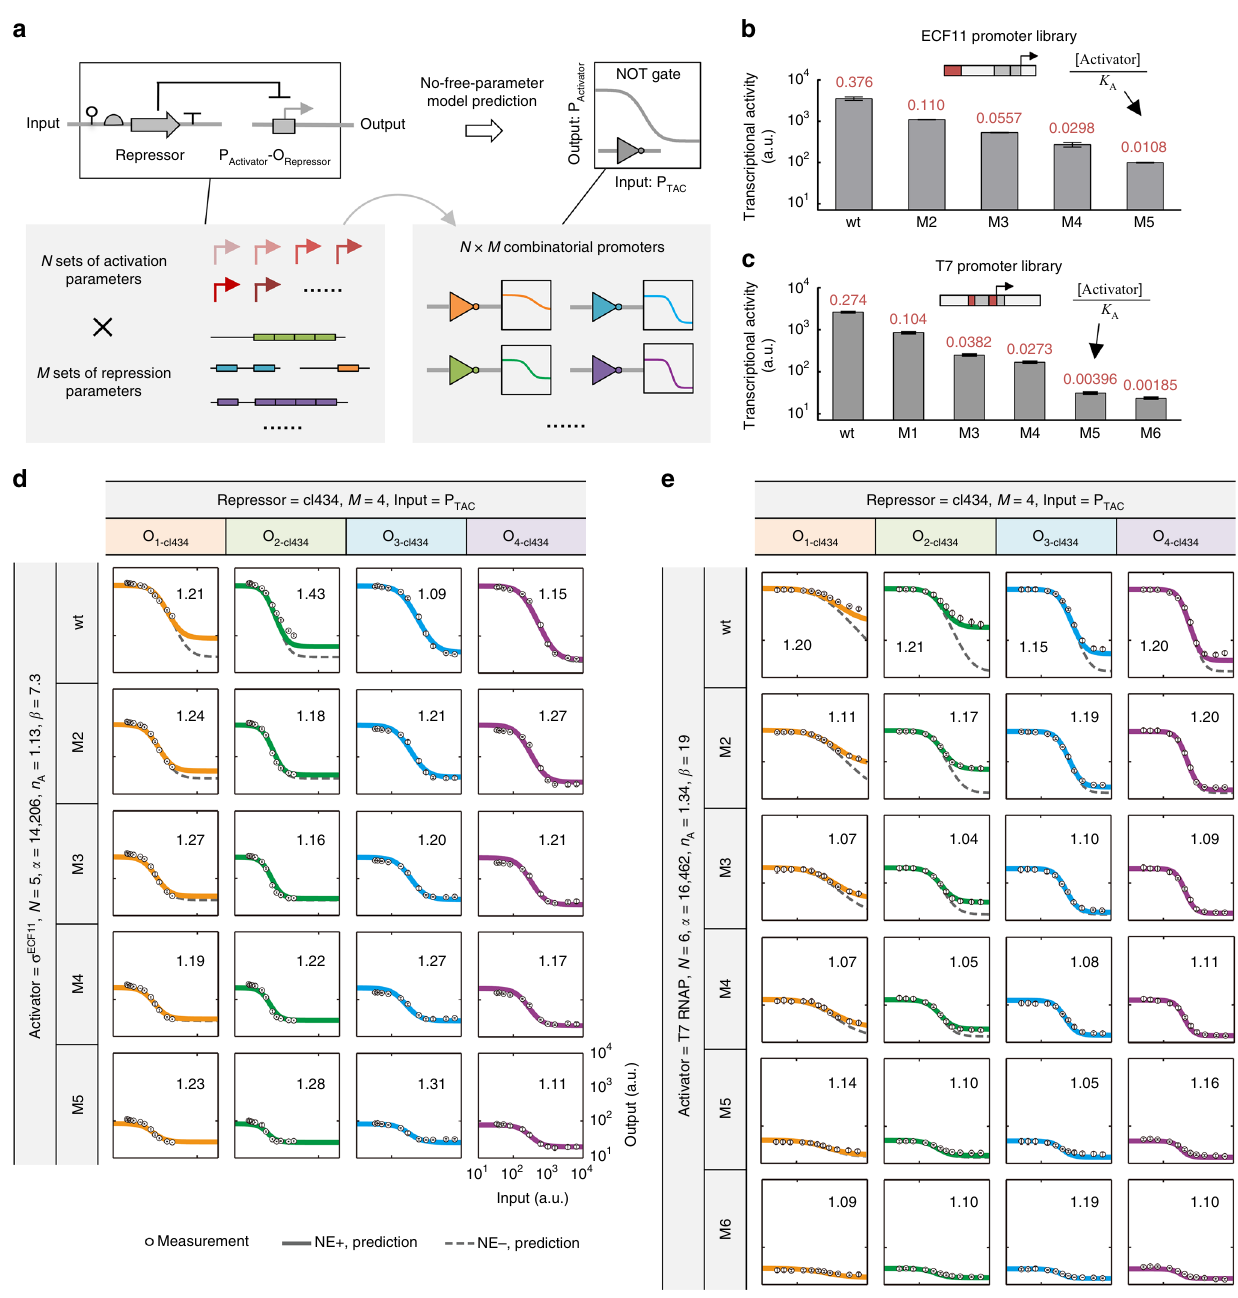
Fig. 4 Activation- and repression-dependent parameters allow the design of combinatorial promoters. a Schematic representation of the combination of N sets of activation-dependent parameters from promoter cores and M sets of repression-dependent parameters from operators used to design N × M combinatorial promoters encoding NOT-gate functions. b and c Construction, characterization, and parameterization of a P ECF11 b and a P T7 promoter library c . The promoter region subjected to mutagenesis is highlighted in red . The corresponding value for [Activator]/ K A is provided for each mutant. d Experimentally determined and predicted response functions of combinations of fi ve σ ECF11 promoter cores and four cI434 operators. Mean relative P log 10 Measurement (cid:2) log 10 Prediction j j , whereby Q represents the number of data points for each response function. e Experimentally determined (-fold) error = 10 1 Q and predicted response functions of combinations of six T7-RNAP promoter cores and four cI434 operators. The mean relative( n -fold) error for the prediction of each response function is given. Data represent the means ± SD from at least three replicate experiments. NE+, with non-equilibrium correction term; NE − , without non-equilibrium